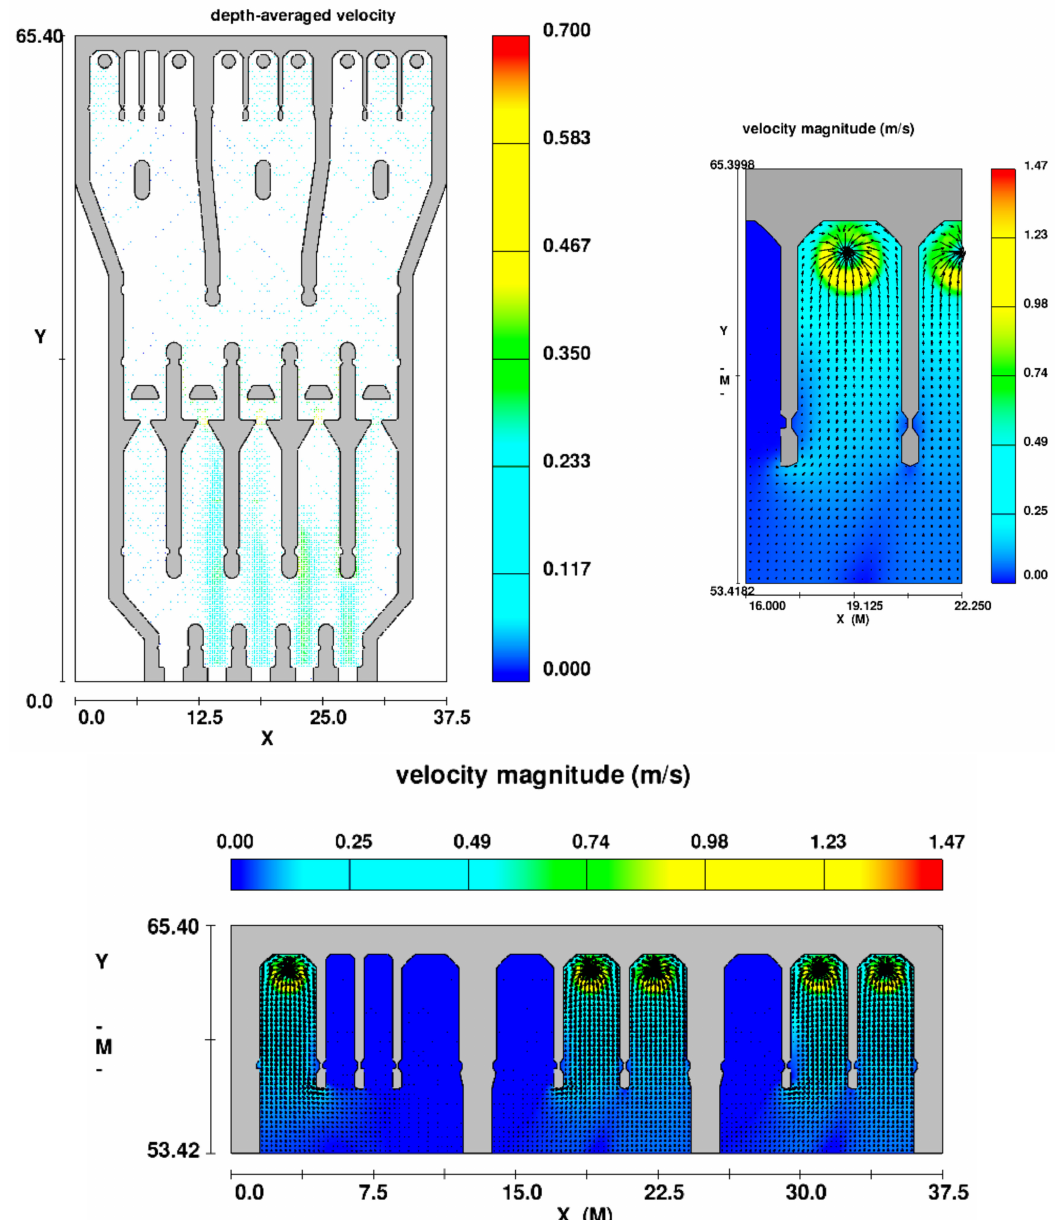
Figure 8. Field vector of velocity at the basin for scenario II—3D